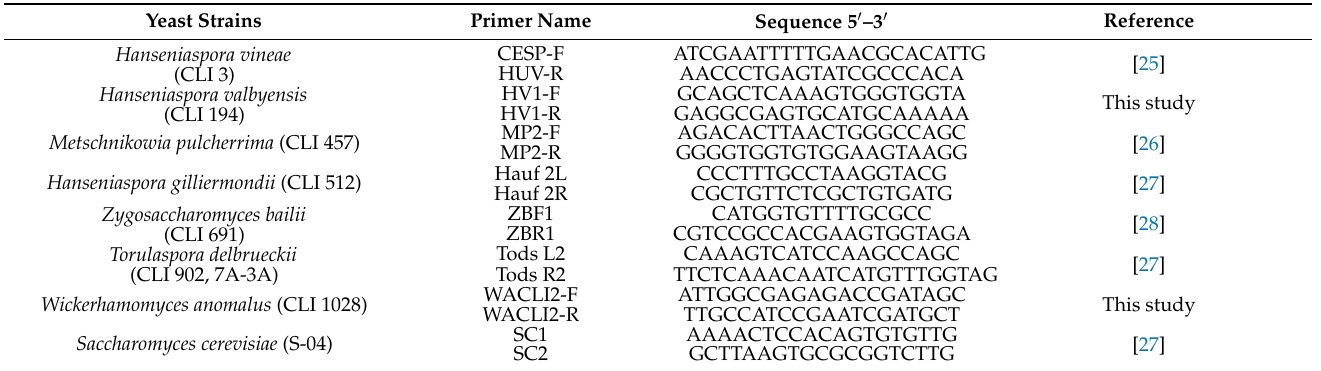
Table 2. Primer sequences used for quantitative real-time PCR